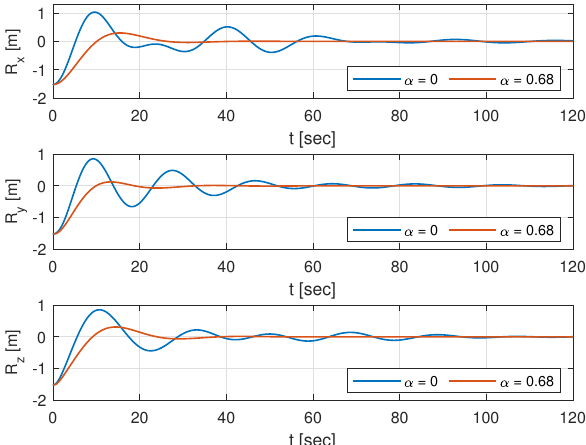
Figure 14. Position of the center of mass of the spacecraft with reduced settling time.